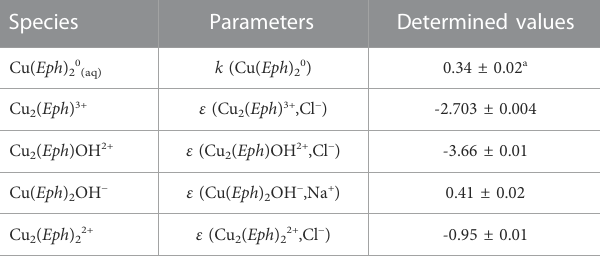
TABLE 5 Speci fi c ion interaction parameters for the Cu 2+ / Eph − species at T = 298.15K. Species Parameters Determined